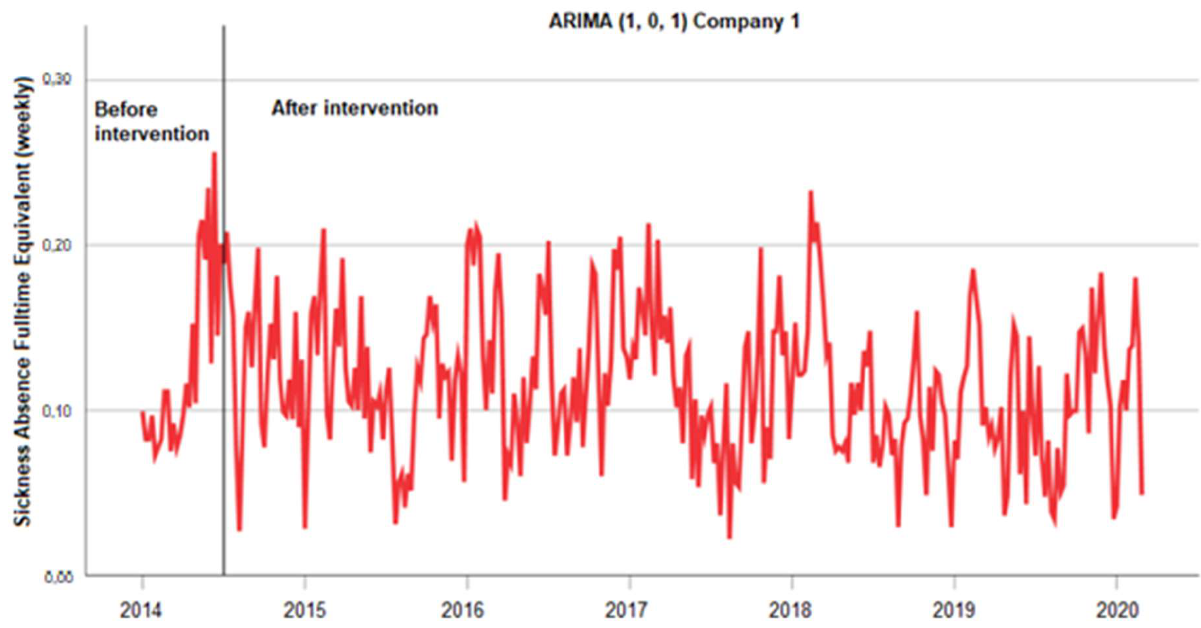
Figure 3. Absenteeism data were collected at company 1 for 321 weeks. After 26 weeks, two firms started a merger (=intervention). The first 26 weeks were used as a baseline period to identify an ARIMA (1, 0, 1) model. The local moving average parameter was 0.123, which was statistically significant (t = 7.243, p < 0.001). The intervention parameter −0.007 was not statistically significant (t = −0.424, p = 0.672).